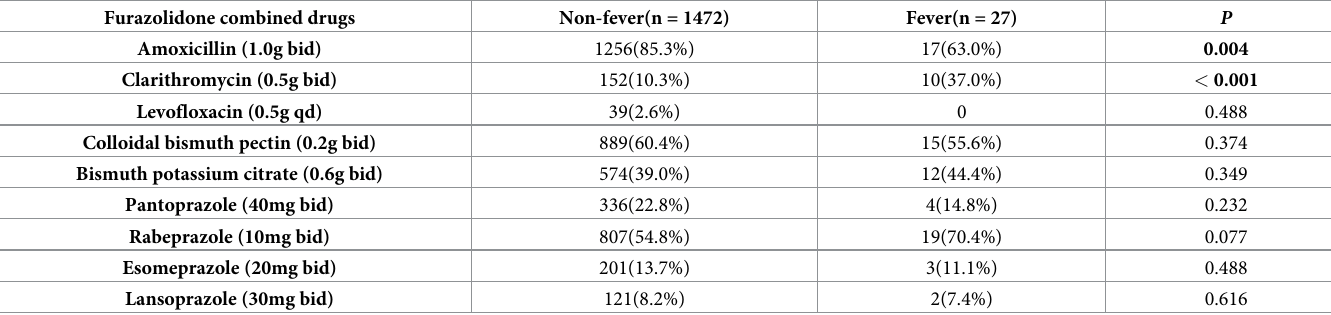
Table 3. Drug dosing and concomitant drugs in patients with or without Furazolidone-associated fever.